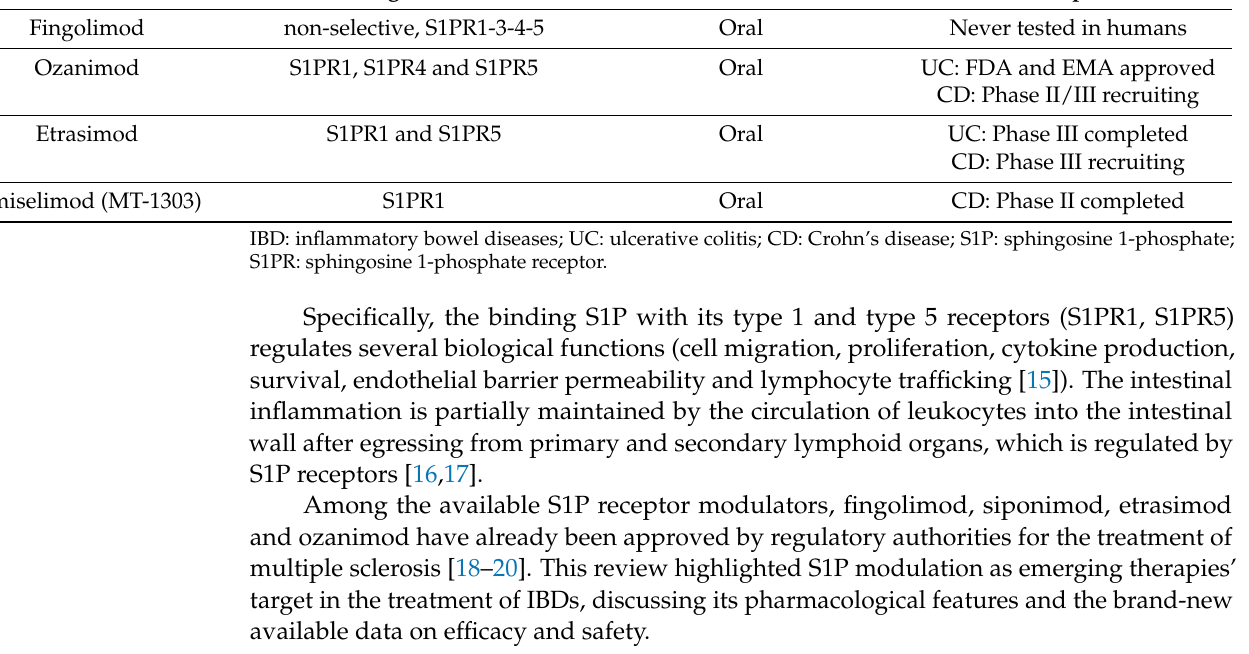
Table 1. Principal characteristics and development phase of S1P receptor modulators in IBD. Molecule Pharmacological Mechanism Administration